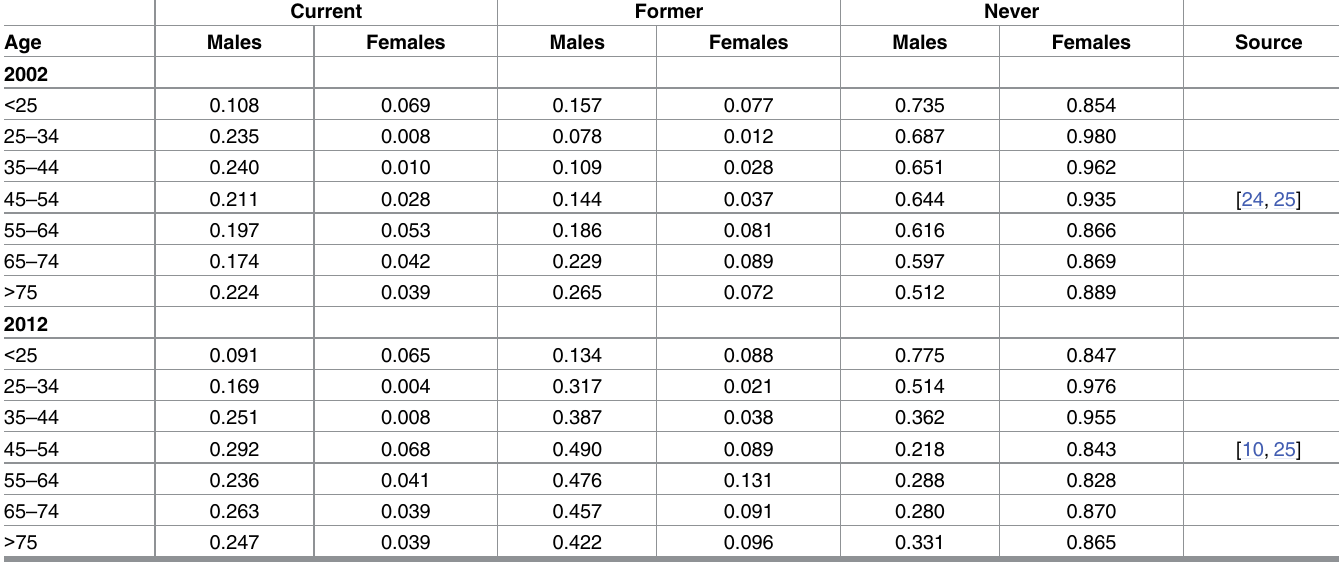
Table 1. Observed smoking prevalencein